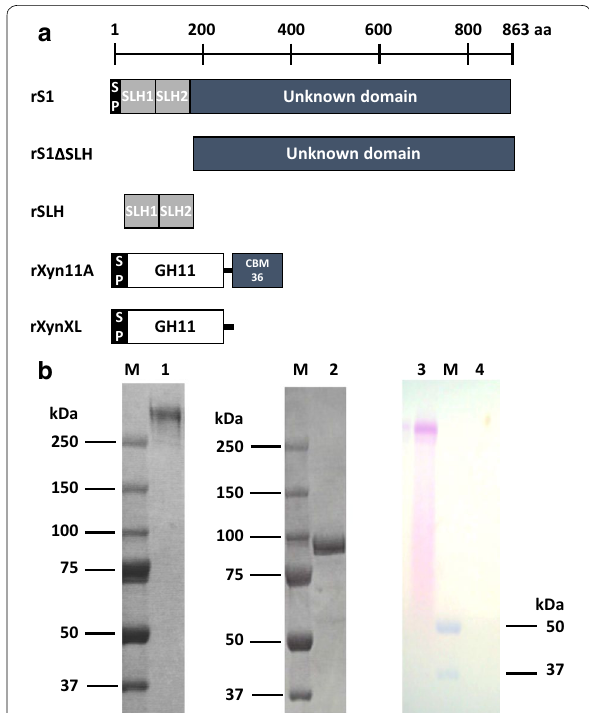
Fig. 1 Molecular architecture of P. curdlanolyticus B-6 S1 protein ( a ) and the detection of glycoproteins ( b ). Recombinant S1 (rS1), rS1 lacking SLH domains (rS1ΔSLH), recombinant SLH domains (rSLH), recombinant Xyn11A (rXyn11A), and rXyn11A lacking CBM36 domain (rXynXL) were designed and expressed as recombinant proteins in Escherichia coli ( a ). SP predicted signal peptide, aa number of amino acid sequence. Coomassie Brilliant Blue staining of purified native S1 (nS1) from a partially-purified multienzyme complex ( b , lane 1) and of rS1 ( b , lane 2). Glycoprotein staining of nS1 ( b , lane 3) and rS1 ( b , lane 4). Lane M, molecular mass markers (kDa). The gel picture does